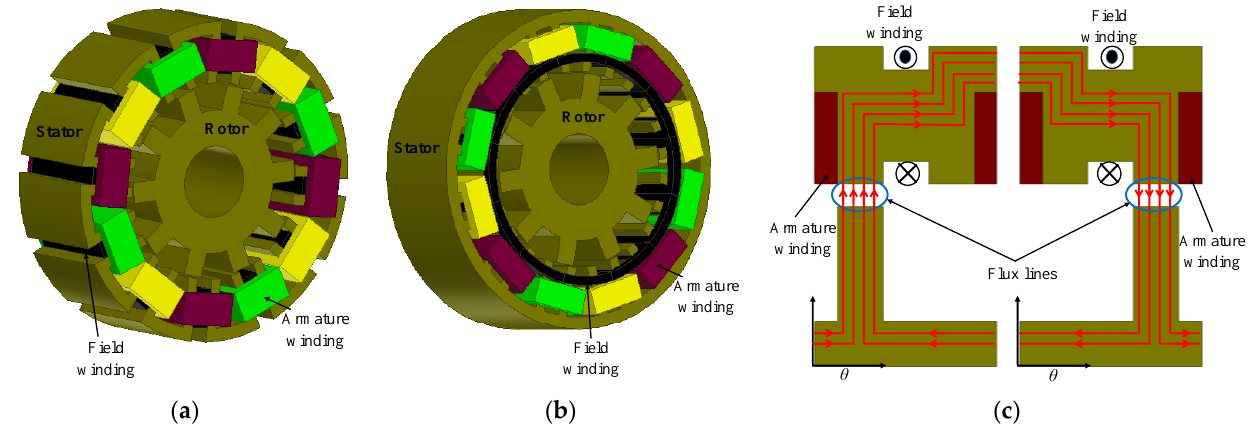
Figure 10. 3-phase FSWFM: ( a ) 12/10-pole design; ( b ) 24/10-pole design; ( c ) principle of polarity switching.